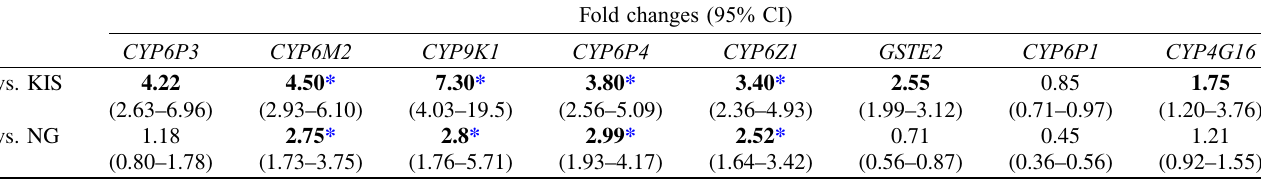
Table 2. Gene expression analysis of fi eld collected Anopheles coluzzii from Yaoundé compared to the susceptible Ngousso (NG) and Kisumu (KIS) strains.